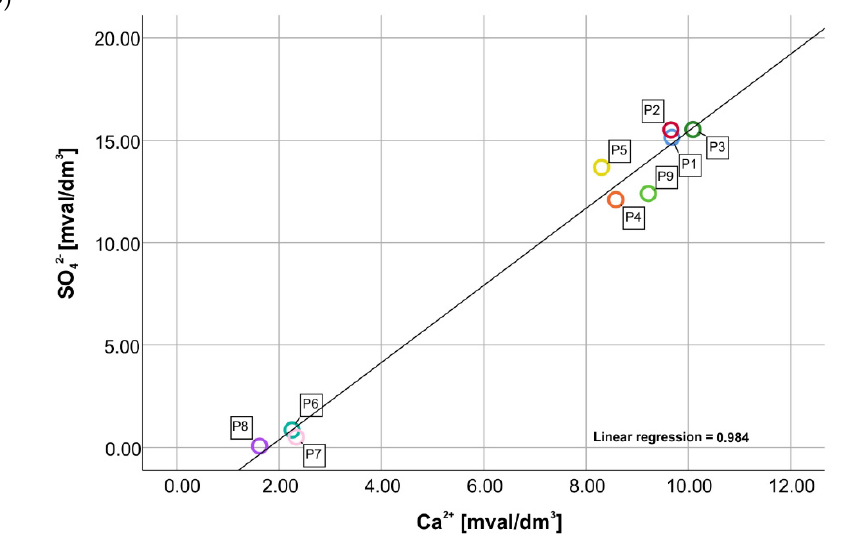
Figure 6. Correlation between concentrations of: ( a ) Na + and Cl − ( b ) SO 42 − and Ca 2+.